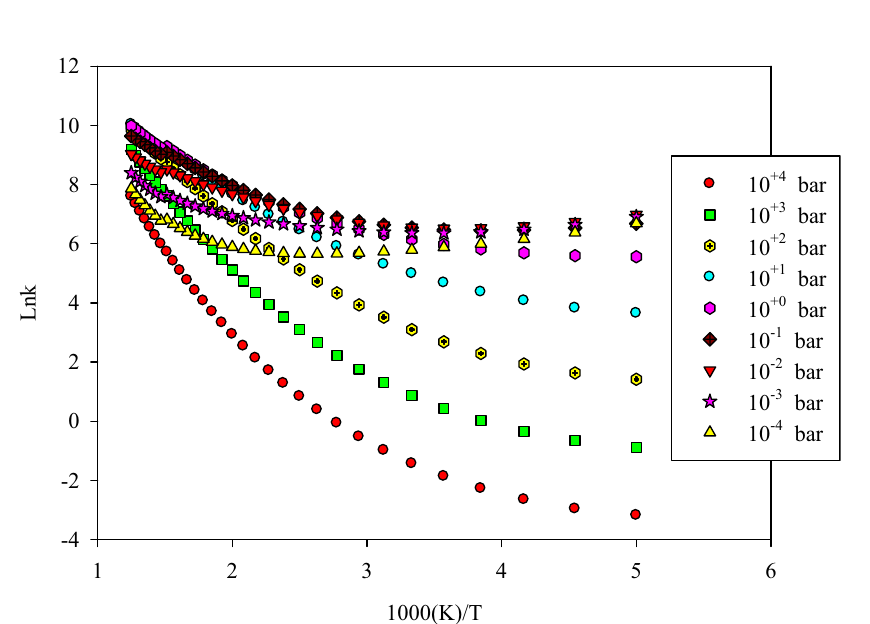
Figure 7. The pressure dependent rate constant calculated by RRKM theory for the reaction of HO 2 addition to β